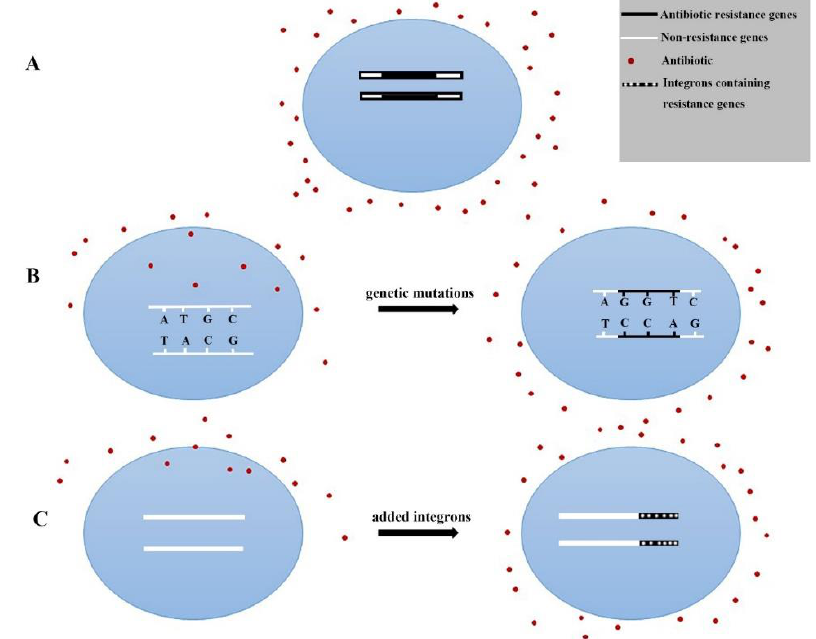
Figure 6. Gene mechanism. ( A ) Inherent drug resistance. Resistance genes exist in bacteria and are